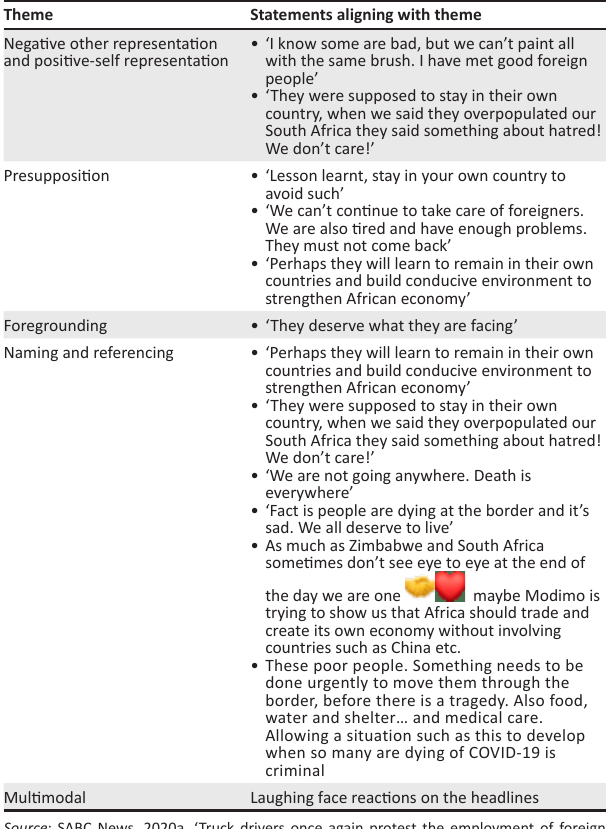
TABLE 1: Viewer comments on migrants situation in South